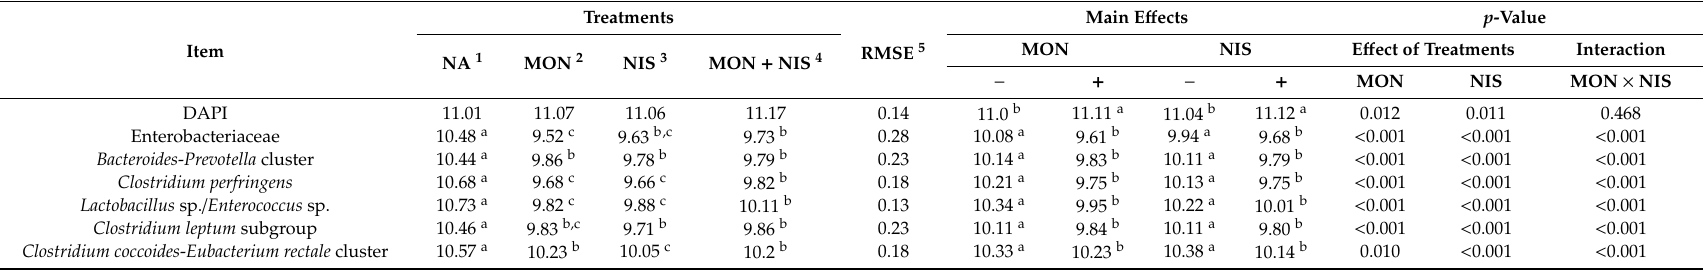
Table 5. The e ff ect of dietary supplementation of nisin alone or in combination with monensin on selected microbial populations (log CFU / g digesta) in the cecal content determined by DAPI staining and fluorescent in situ hybridization (FISH), Experiment 1.